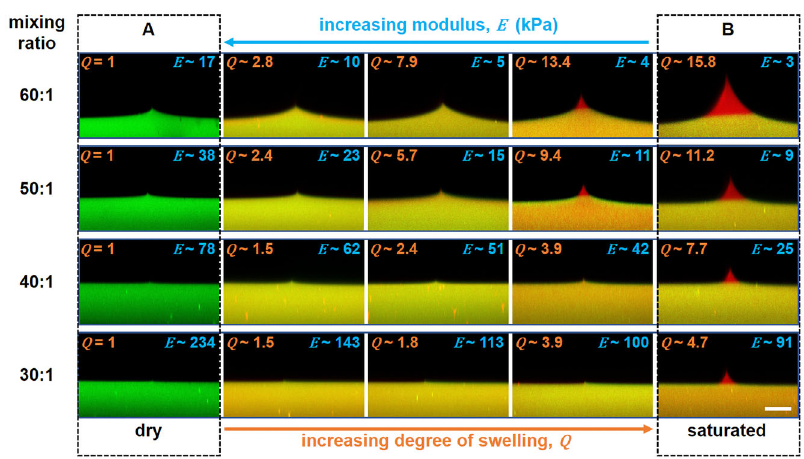
Fig. 3 Qualitative map of cross-sectional confocal images of contact line with varying degrees of crosslinking and swelling. Each row of pictures from top to bottom corresponds to samples with a dry modulus ranging from 17 kPa to 234 kPa, and a base/crosslinker ratio from 60:1 to 30:1, respectively. Orange numbers inside each image indicate the degree of swelling and blue numbers indicate the macroscopic modulus. Column A and B display the dry and saturated conditions, respectively. Scale bar: 20 µ